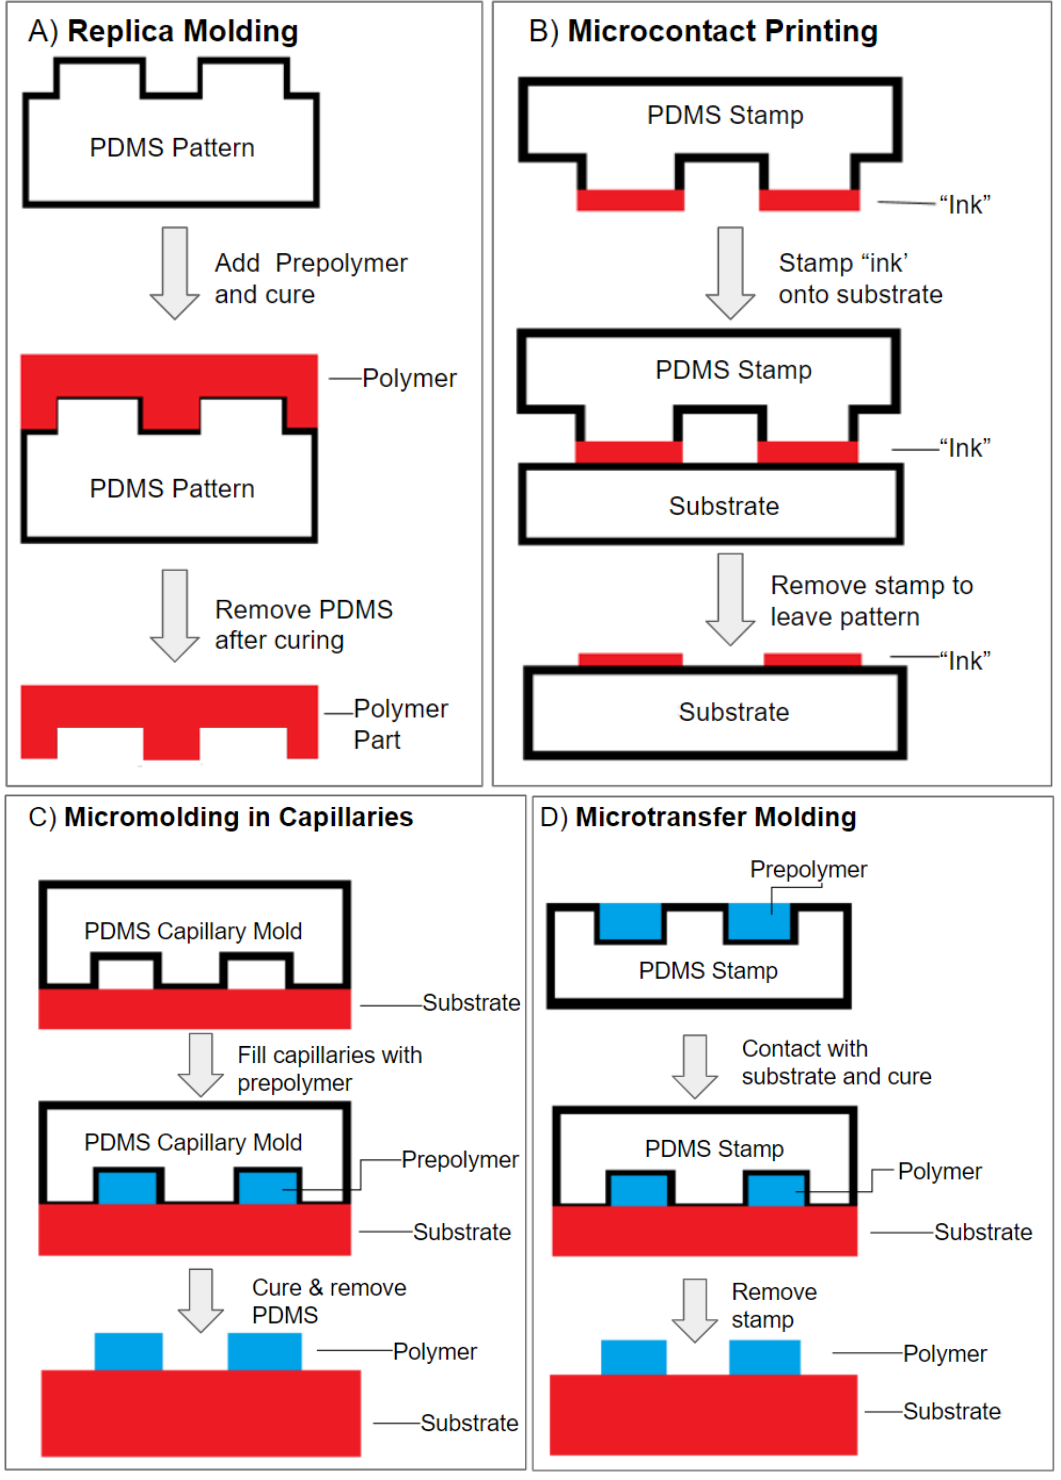
Figure 3. The four core techniques of soft lithography. ( A ) Replica molding. ( B ) Microcontact printing. ( C ) Micromolding in capillaries. ( D ) Microtransfer molding.